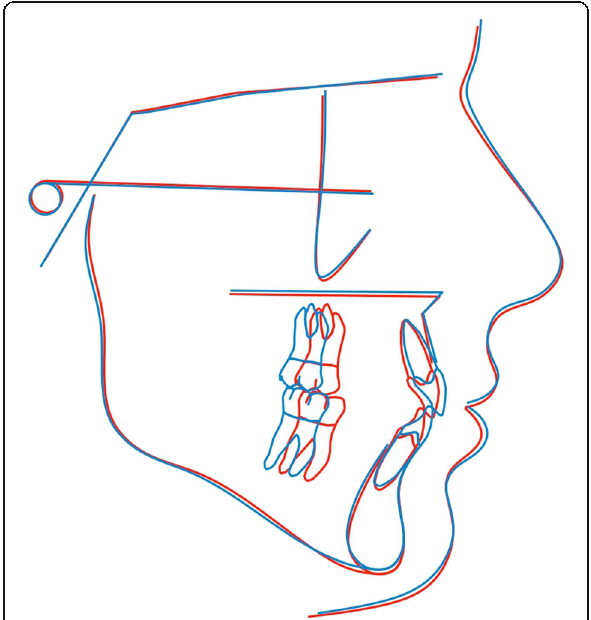
Fig. 4 Average tracings at the start of treatment using Procrustes superimposition. Blue line, non-extraction; red line, extraction